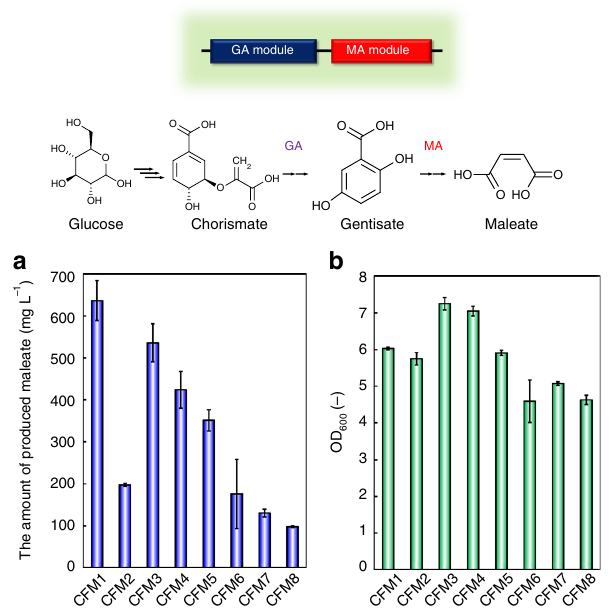
Fig. 5 Growth and maleate production by strains CFM1 – 8 after 48 h of cultivation. a The amounts of produced maleate and b OD 600 values. Data are presented as the mean ± standard deviation of three independent experiments ( n =